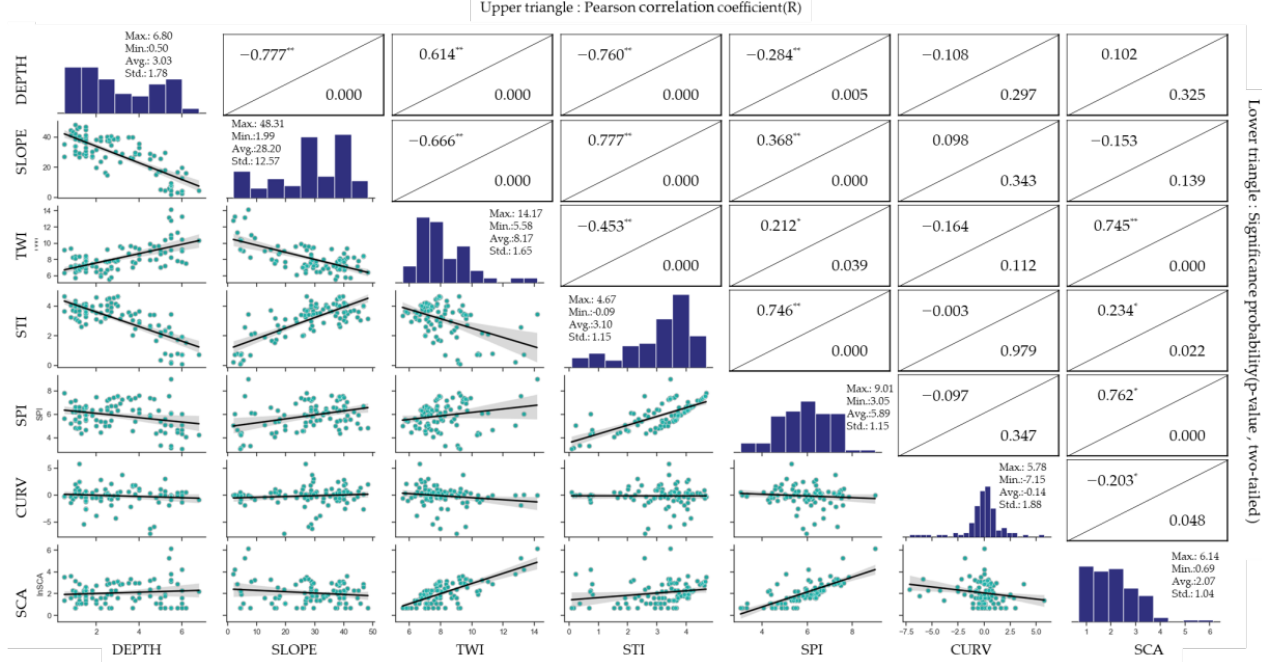
Figure 4. Correlation matrix for metamorphic rock (*: Significant at the 0.05 probability level. **: Significant at the 0.01 probability level).